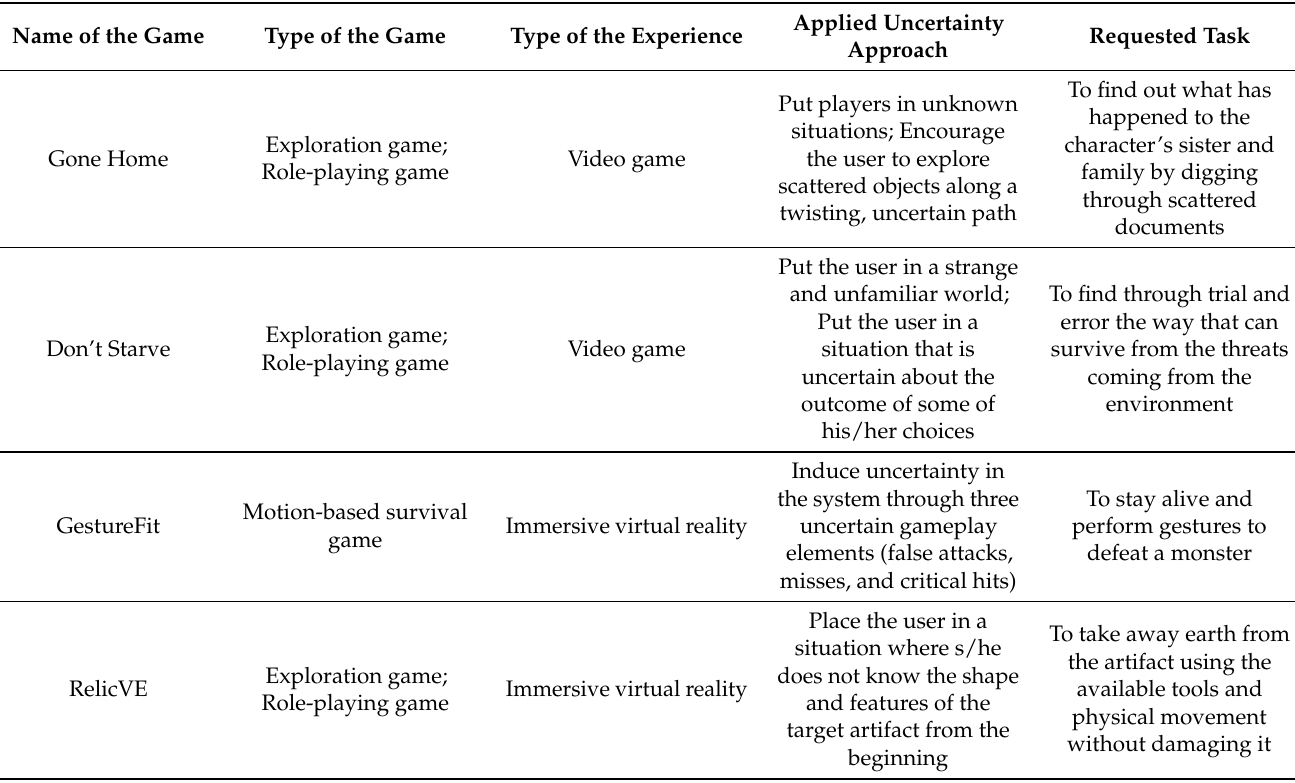
Table 1. Key features of the games reviewed in the related work section.